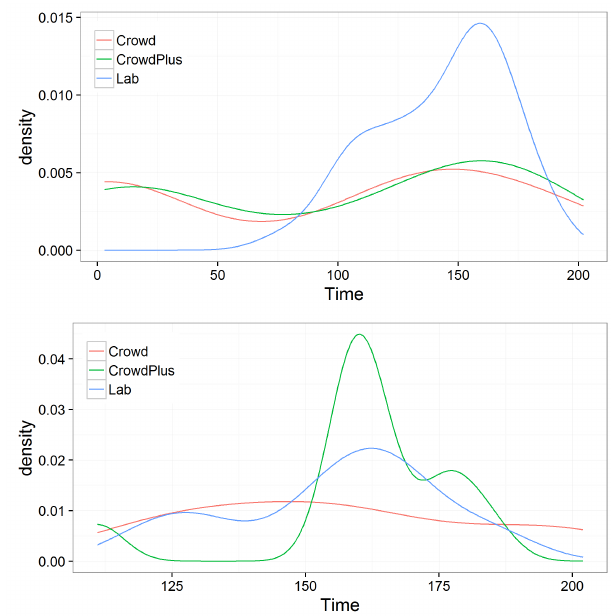
Figure 2. Estimated density of survival times using each participants minimum and maximum survival time (top) and only the maximum survival time (bottom) Due to the high amount of low survival times for both crowd groups, we analysed the data that included only the highest survival time for each participant.